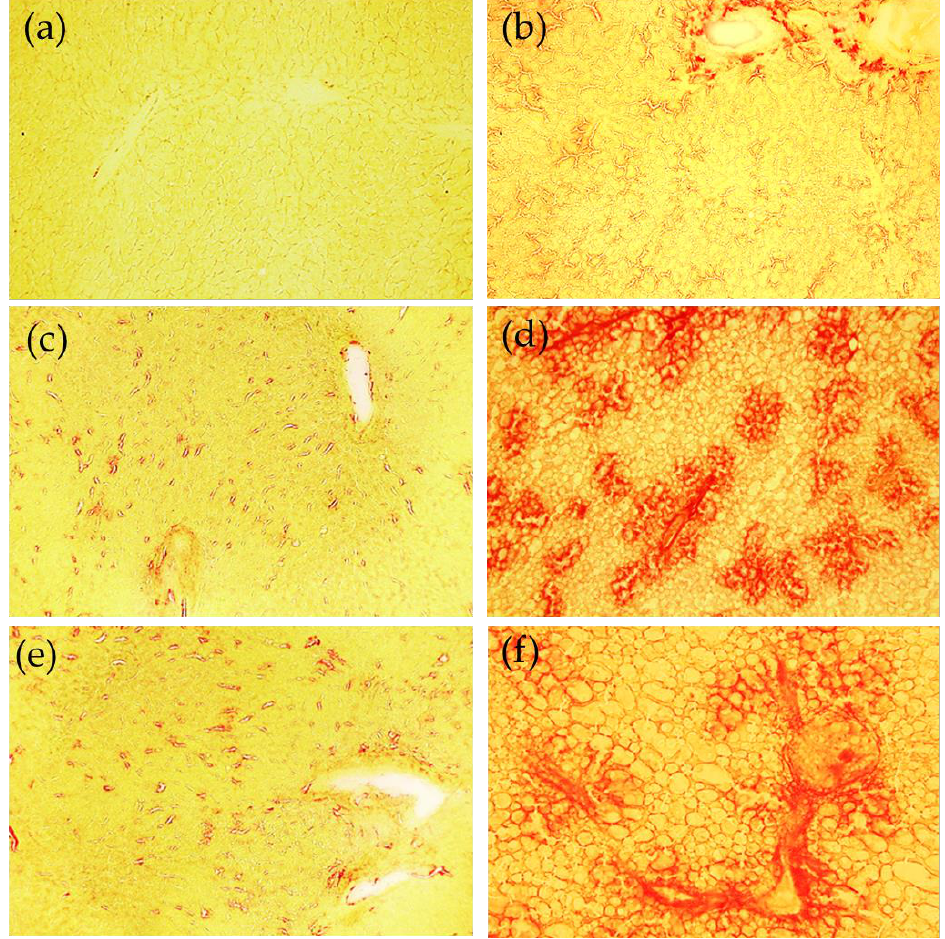
Figure 4. Examples of images collected from the cryostatic liver tissue sections following the Sirius red staining procedure. Fibrous collagen is evidenced as red structures. Control 2 weeks ( a ), 4 weeks ( c ), 8 weeks ( e ); MCD diet, 2 weeks ( b ), 4 weeks ( d ) and 8 weeks ( f ). Bar: 200 μm. In MCD rats, correlation analysis showed that liver Zn levels were positively correlated with TIMP-1 and inversely correlated with RECK, TBARS and ROS (Table 3). No correlation was found between Zn versus MMPs and GSH. Table 3. Correlation between liver Zn and Fe versus MMPs, TIMPs, RECK, TBARS, ROS and GSH.